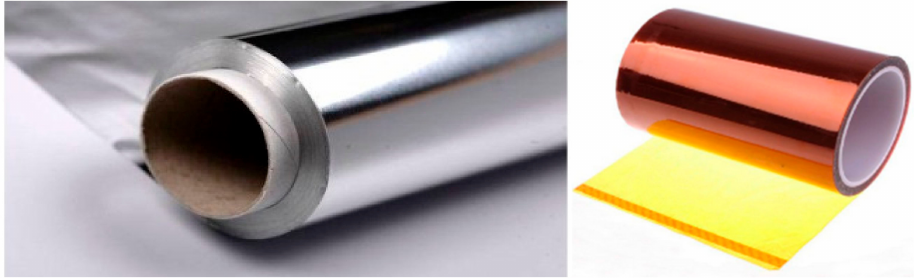
Figure 1. ( left ) commercial aluminum film; ( right ) adhesive